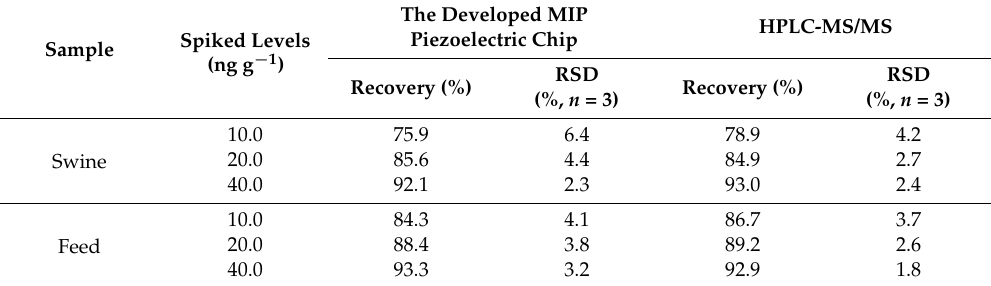
Table 1. Recoveries of RAC in spiked swine and feed samples using the MIP piezoelectric chip and